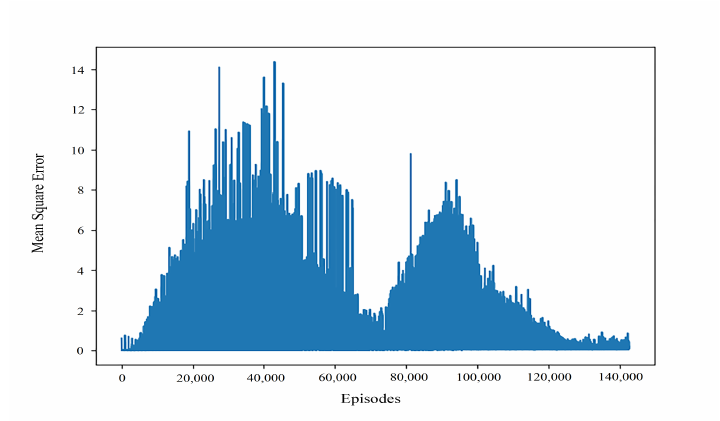
Figure 5. Mean square error when the learning rate is 0.0001 and the convergence effect is good.